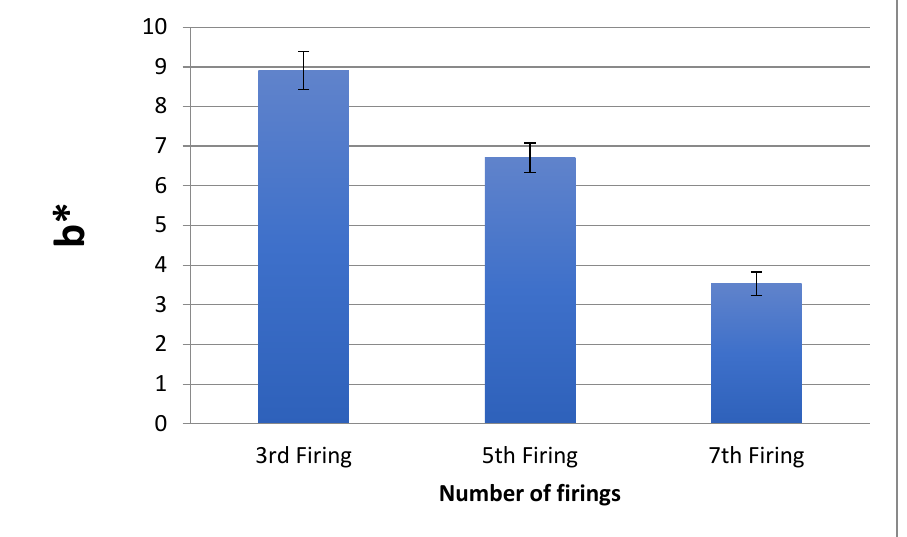
Figure 3. a* comparison of samples after the third, fifth, and seventh firings.